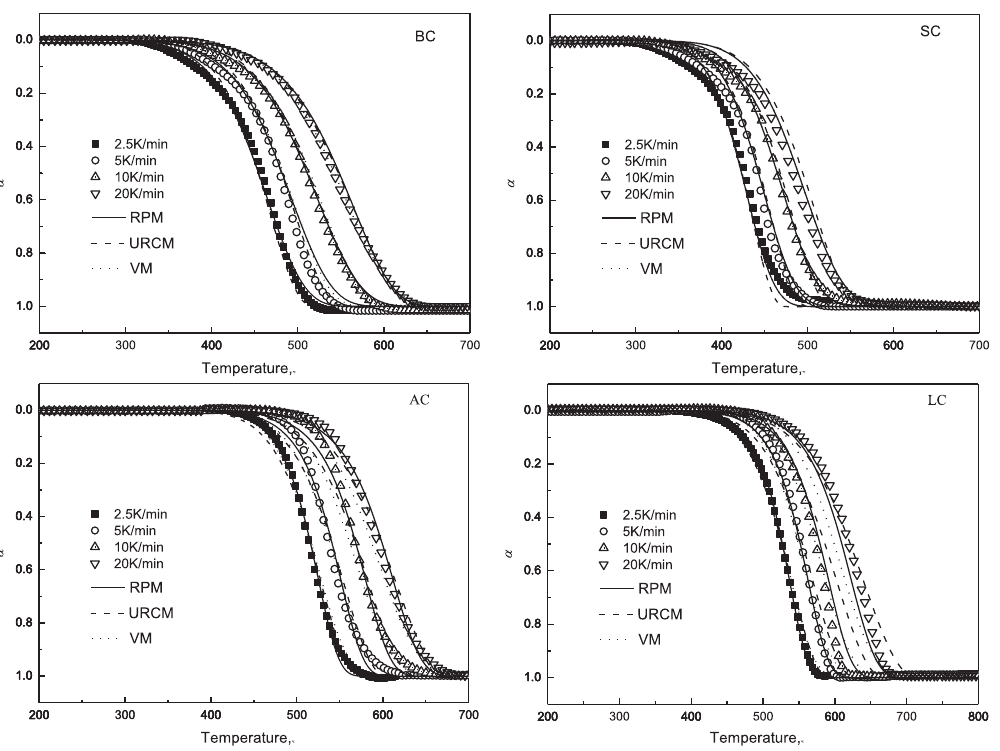
Figure 4: Relationship between calculated value and experimental data under different heating rates.